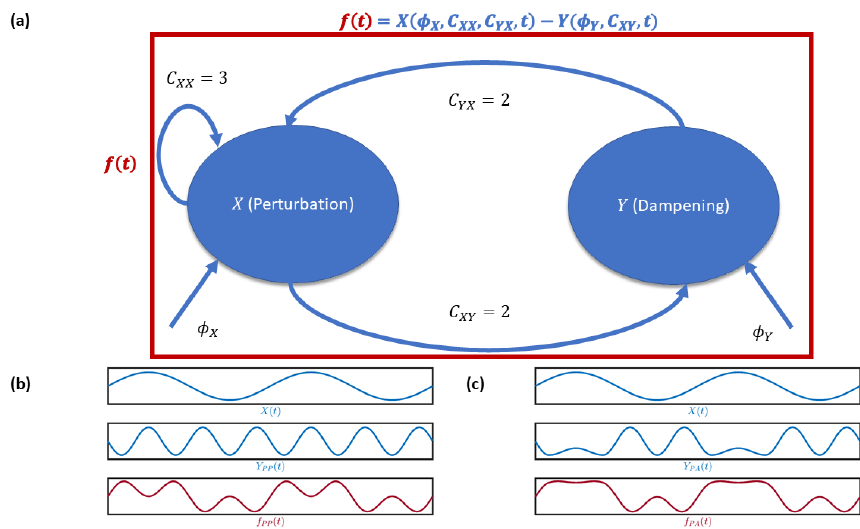
Figure 3. A system with directional cross-scale interactions. (a) A variable f (t) made of two components, X and Y , connected through C XY and C YX in a perturbation–dampening scheme, so that f (t) = X(t) − Y(t) . Both X and Y receive inputs φ X and φ Y , respectively. C XX allows X to grow first. Depending on both inputs and connections, some phase–phase or phase–amplitude interactions between X and Y can occur. (b) An example of a phase–phase interaction, with every fourth ridge of Y PP coinciding with a ridge of X , with f PP (t) = X(t) − Y PP (t) (top, middle, and bottom panels, respectively). (c) An example of a phase–amplitude interaction. X and Y PA only interact when X reaches a ridge, in which case the Y PA amplitude, if lowered, yields f PA (t) (top, middle, and bottom panels, respectively; adapted from Onslow et al.,